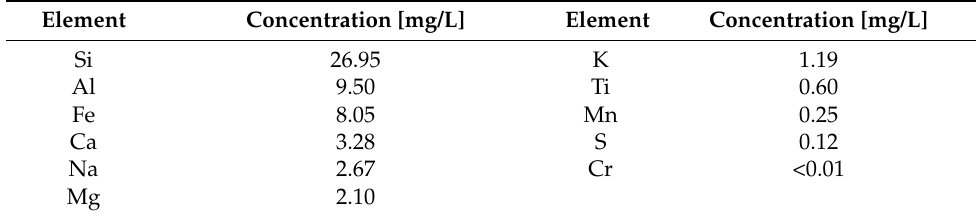
Table 1. Tailings chemical characterization test (ICP).